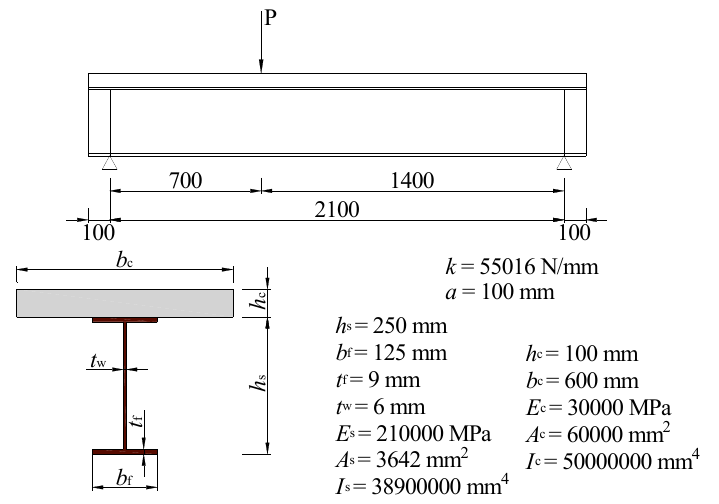
Figure 3. Geometrical and mechanical characteristics of Wang’s beam [22,23].